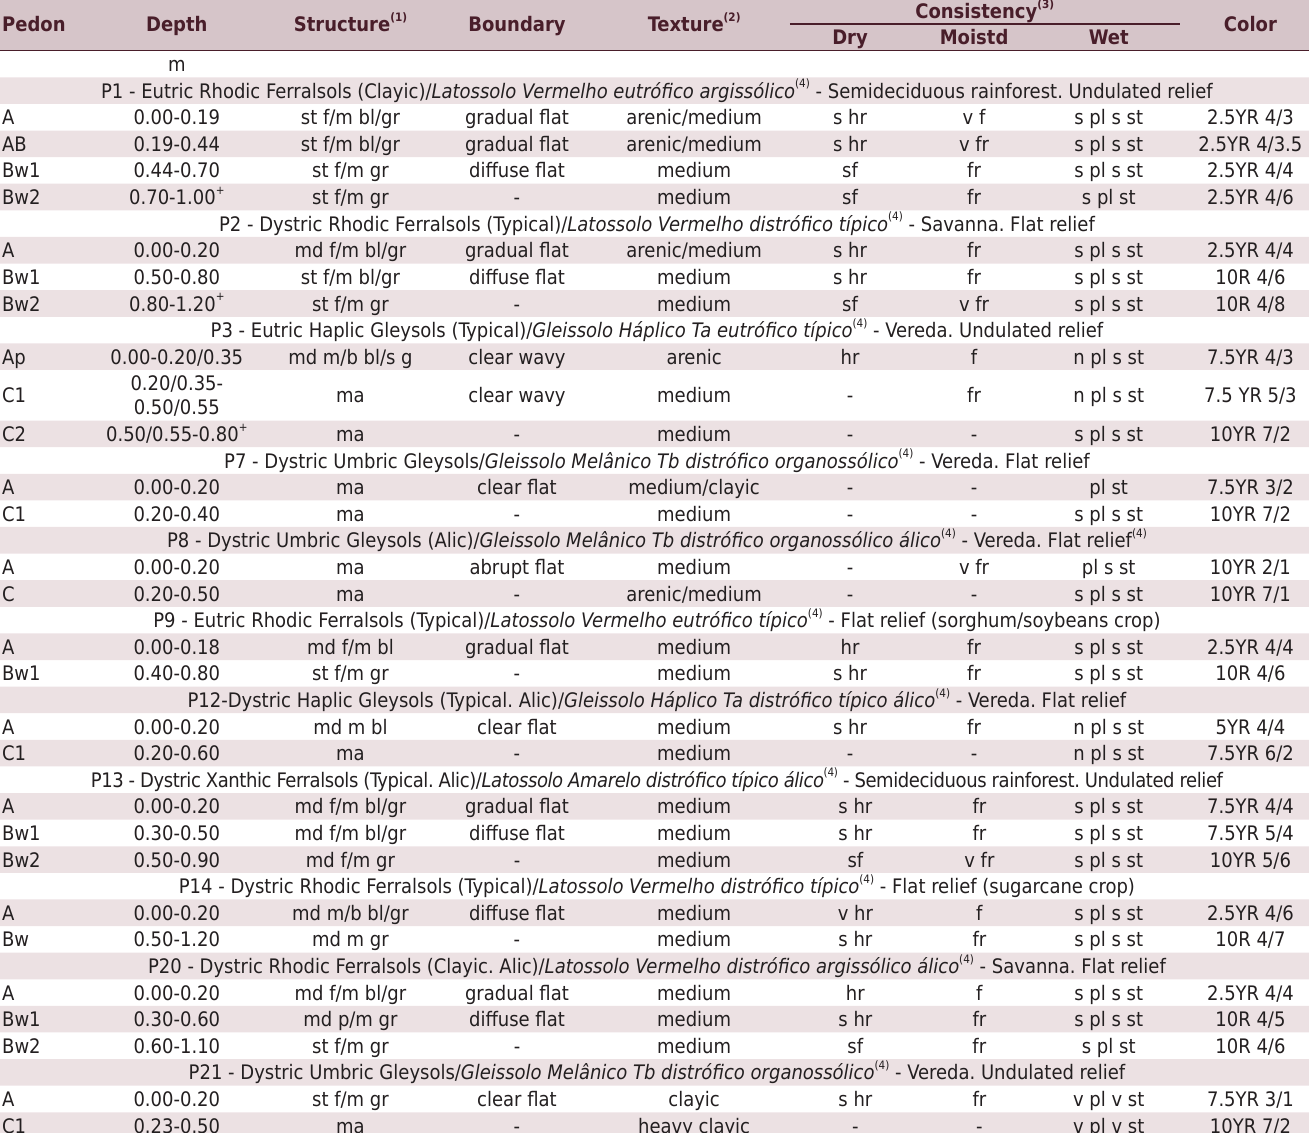
Table 1. Morphological properties of some selected studied soils Pedon Depth Structure